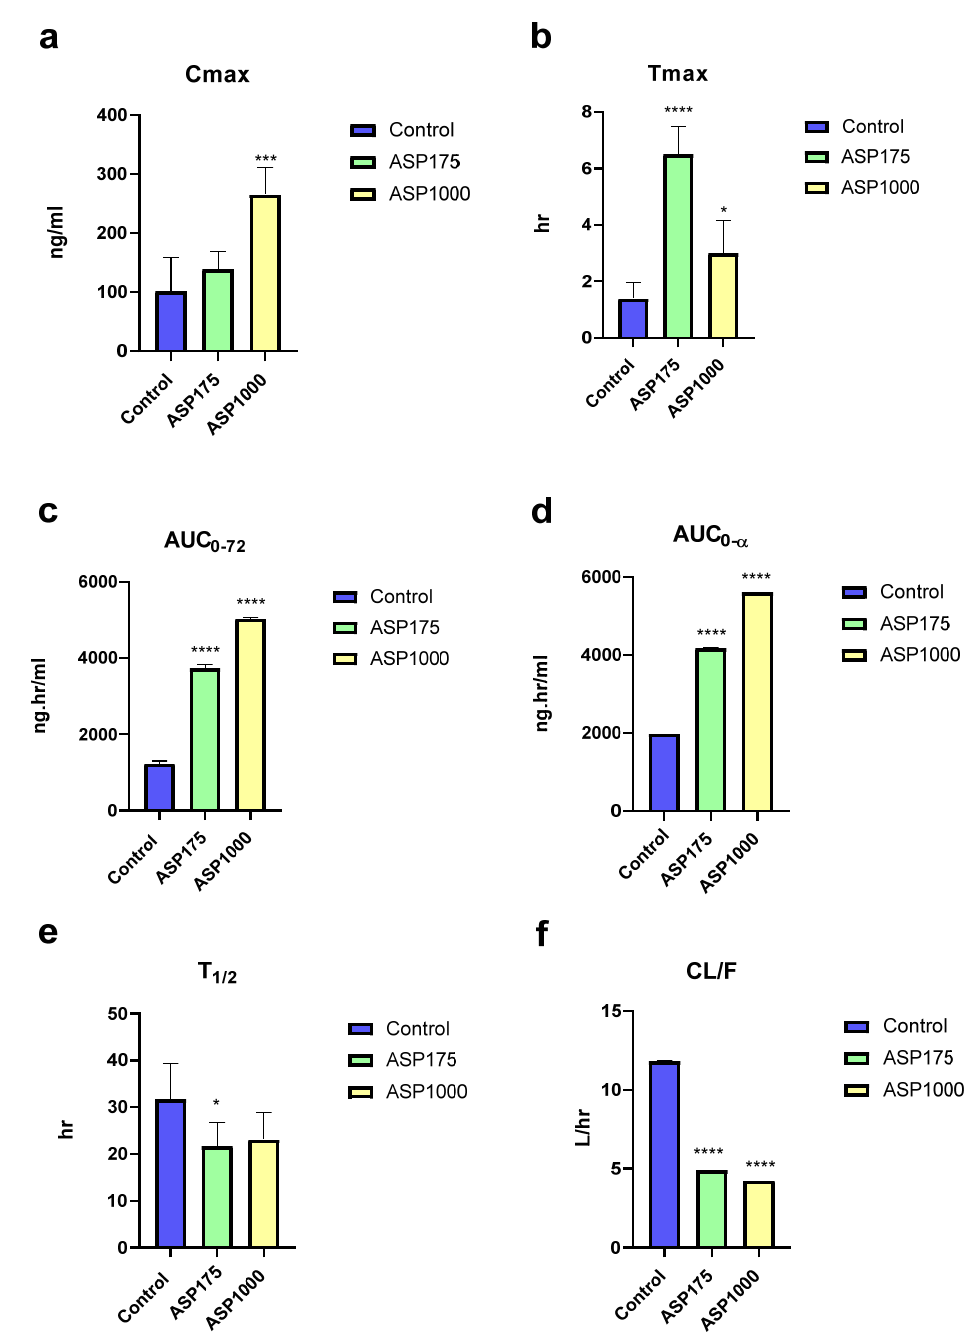
Figure 1. ( a – f ) Alteration in the main PK parameters ( a ) Cmax, ( b ) Tmax, ( C ) AUC 0-72 , ( d )AUC 0- α , ( e ) T 1/2 , ( f ) CL/F of ERL after four weeks administration of 1000 and 175 mg/kg ASP in rats compared to control ( n = 5). p -values of 0.05 were considered statistically significance, where * p < 0.05, *** p < 0.001, and **** p < 0.0001.